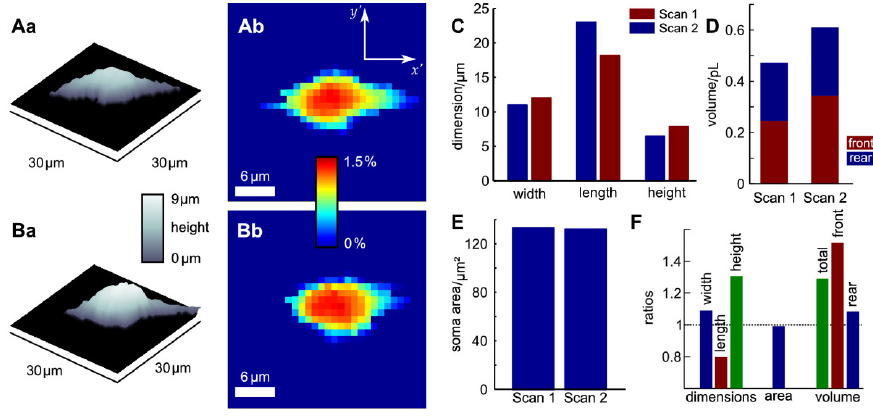
Figure 9. Changes of cell body dimensions of a migrating oligodendrocyte progenitor cell. Aa and Ba show three-dimensional representations of the observed cell, Ab and Bb show the approximated cell soma. C – F show the changes in cell body dimensions between the two scans. While the area of the cell remains constant, the volume increases particularly at the frontal part of the cell. Extrapolations of the volume from two-dimensional micrographs would not have detected this volume change. Figure taken from [65], licensed under a